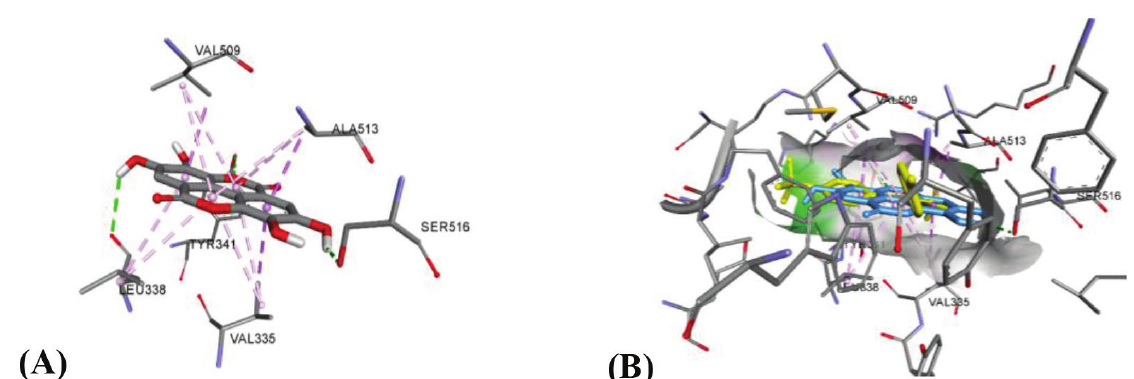
Figure 10. 3D visualization ( A ) interaction of ellagic acid with amino acids residues of the active site of COX-2 inhibitor and ( B ) celecoxib compatible conformation (yellow molecule) and ellagic acid (blue molecule).